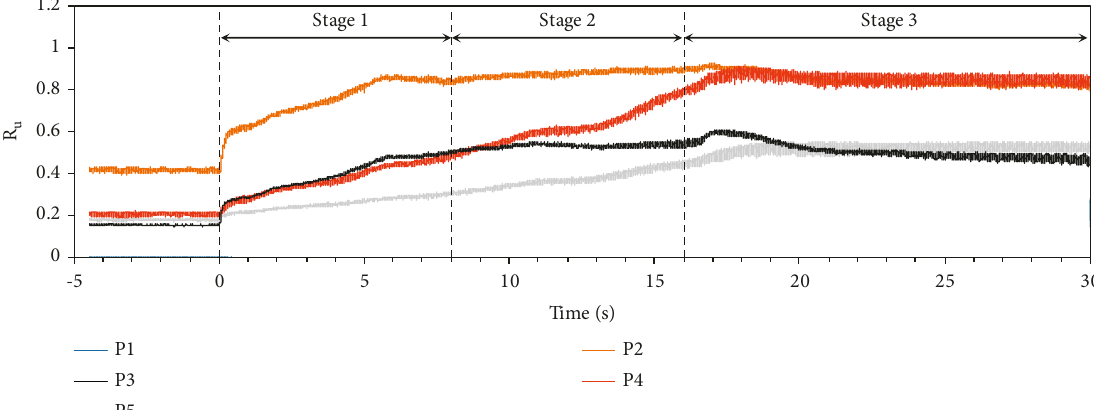
Figure 9: Evolutions of the ratio of excess pore pressure with time in test T 3.